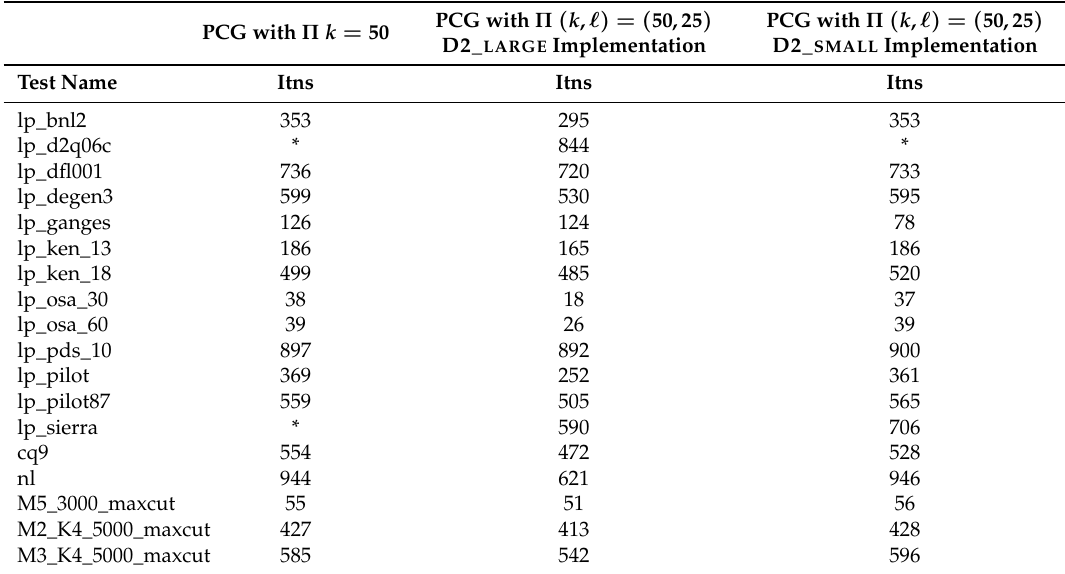
Table 5. Solution of systems with H = A Θ A T , A ∈ IR m × n : CG coupled with Coordinate-LMP Equation (12) k = 50, CG coupled with Coordinate-LMP Equation (16) ( k , (cid:96) ) = ( 50,25 ) and D2_ LARGE implementation, CG coupled with Coordinate-LMP Equation (16) ( k , (cid:96) ) = ( 50,25 ) and D2_ SMALL implementation. Number of PCG iterations